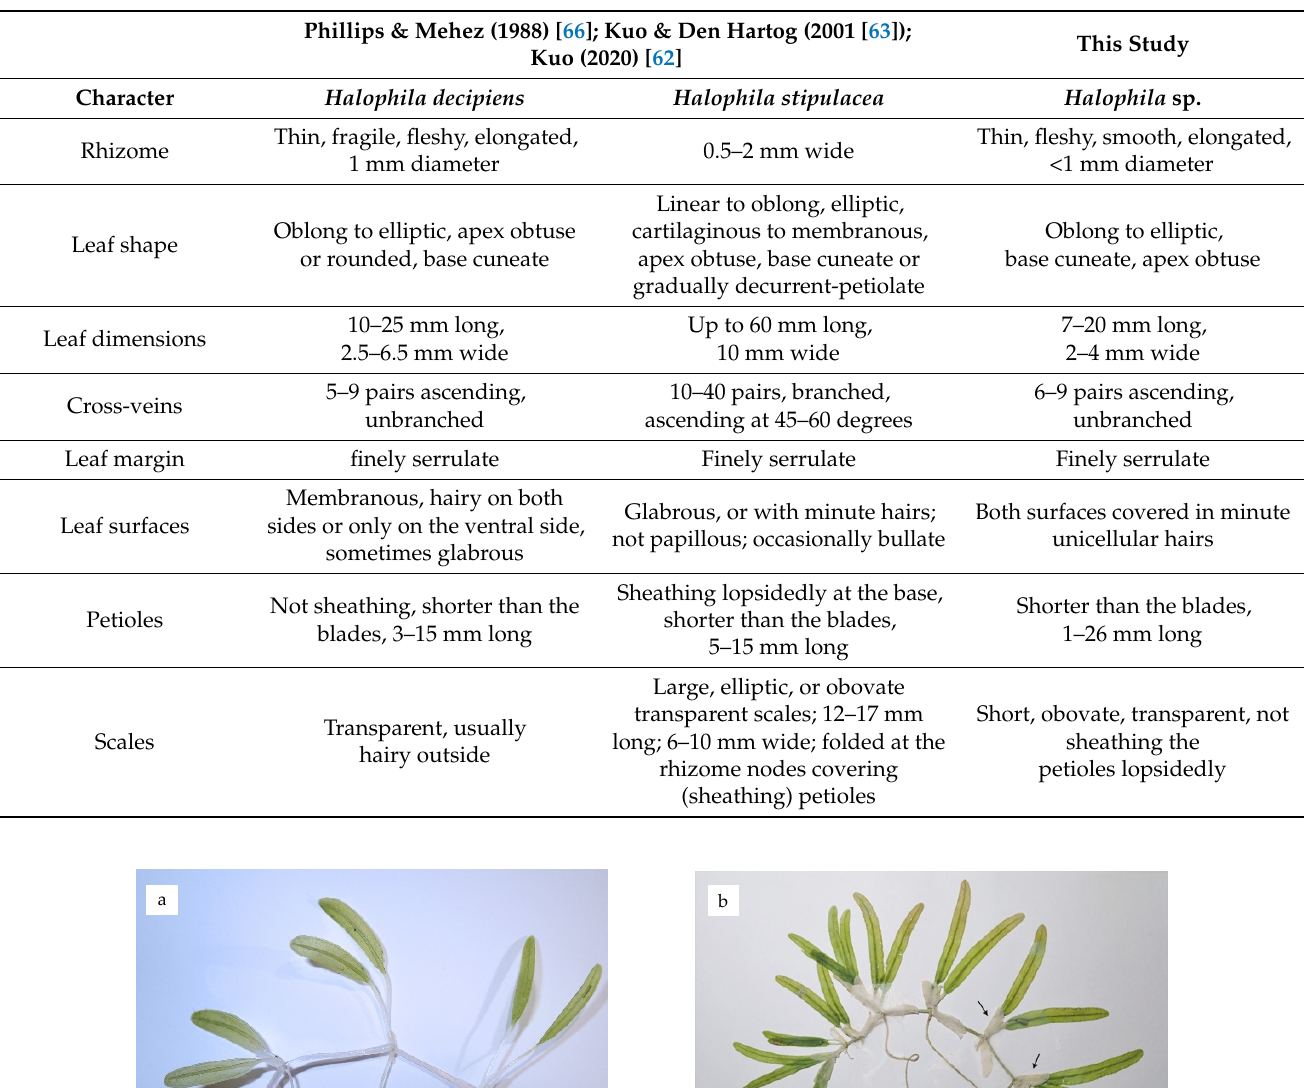
Table 2. Vegetative characters of Halophila sp. compared to H. decipiens and H. stipulacea .